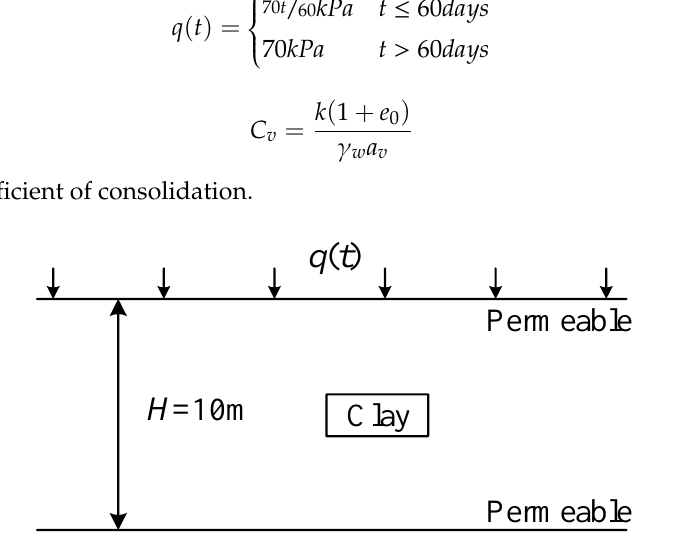
Figure 9. The calculation diagram for all three cases. Table 2. Calculation parameters.